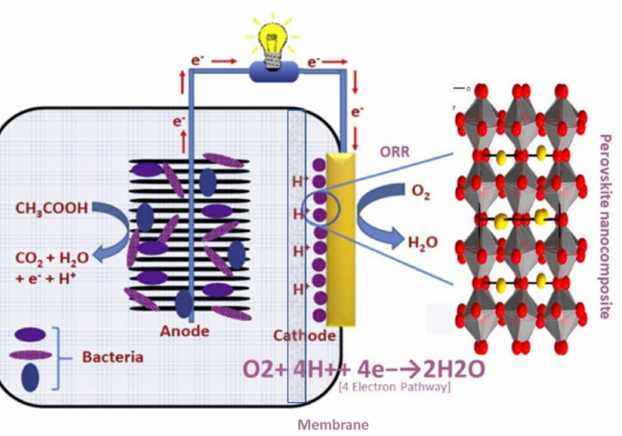
Figure 1. Graphical representation of a single-chambered MFC with perovskite ORR catalyst having a four-electron